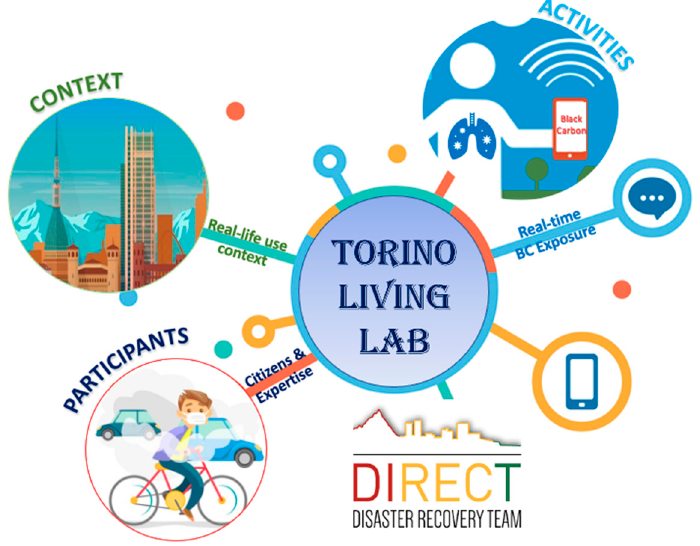
Figure 2. Torino Living Lab#1. LL#1 Project Logo.